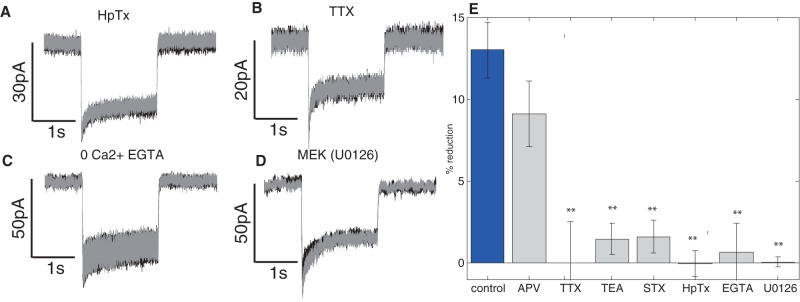
Kv4.2 channels are responsible for DED and the process requires Ca2+ and MEK.(A–D) Example current measurements before (black) and after stimulation (grey) showing that DED is blocked by HpTx (A) and TTX (B). Moreover DED does not happen in the absence of Ca2+ (C) and is blocked by MEK inhibitor U0126 (D). (E) Bar graph summarizing effect of different drugs. When no drugs are applied 13%±1.7% DED is observed. Application of TTX (1 uM), TEA (20 mM) and Stromatotoxin-II (100 nM) reduced the amount of DED to ∼3% while application of Hptx (100 mM) or U0126 (10 uM) or removal of calcium from external solution completely abolishes DED. The dendritic excitability was measured using 2 s pulses and the DED was quantified as a percentage change between the averaged peak current before and after stimulation. For each treatment significance of differences between the excitability before and after the stimulation was tested with two tailed heteroscedastic Student's t-test. Comparison between conditions was conducted by one-way ANOVA with Tukey post hoc test and showed no significant difference between control and APV (p = 0.08) and a statistically significant difference between control and all other conditions with p<0.001.